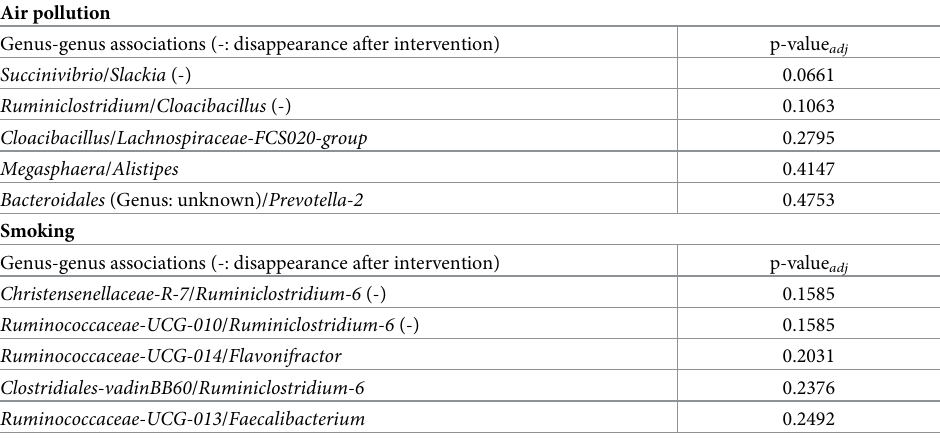
Table 7. Differential associations of genera. Smallest five adjusted two-sided randomization-based p-values for 10,000 permutations of the intervention assignment following a matched-pair design.